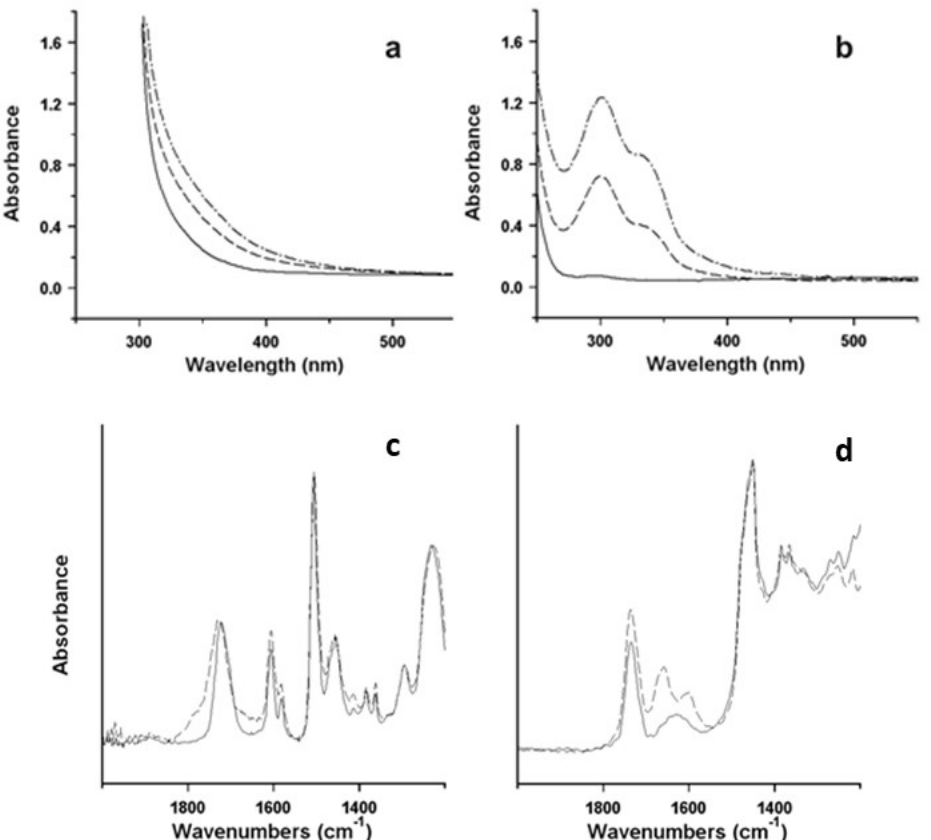
Figure 10. UV-vis spectra of reference films of: ( a ) the epoxy vinyl ester resin before (solid line) and after 24 (dashed line) and 120 h (dash-dotted line); ( b ) the aliphatic ER before (solid line) and after 100 h (dashed line) and 200 h (dash-dotted line) accelerated photo-ageing. ATR-FTIR spectra between 2000 and 1250 cm − 1 of: ( c ) the epoxy vinyl ester resin before (solid line) and after 1000 h (dashed line) isothermal treatment; ( d ) the aliphatic ER before (solid line) and after 200 h (dashed line) photo-ageing. Image reprinted with permission from [71].